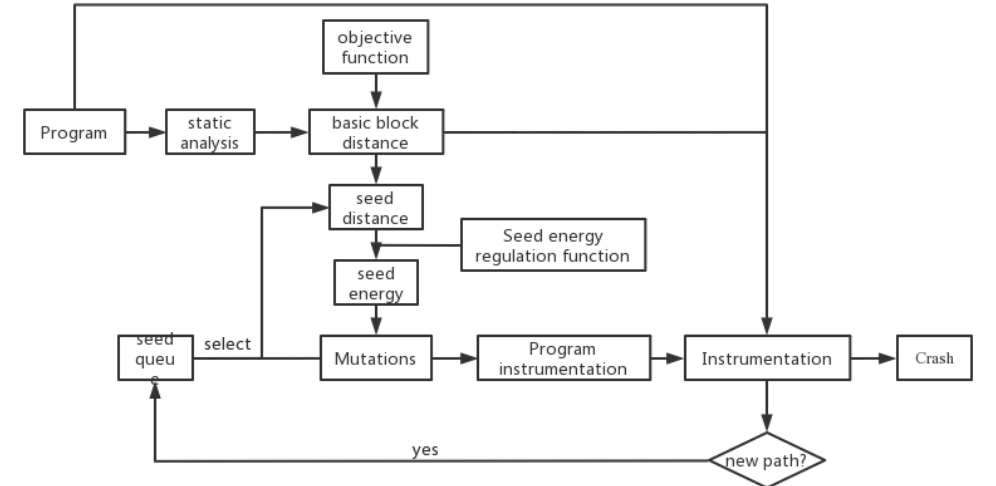
Figure 2. Technical framework of directional grey-box fuzzing.